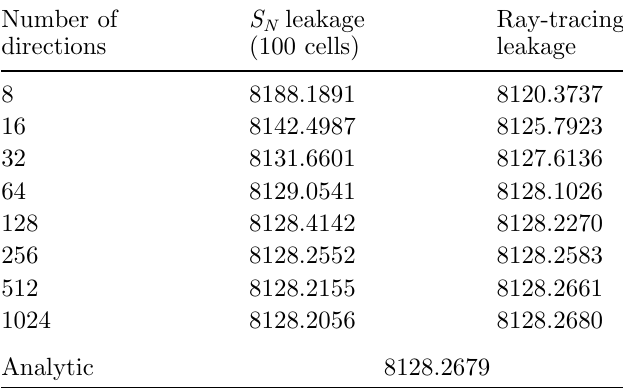
Table 2. Convergence of the ray-tracing and S with the number of